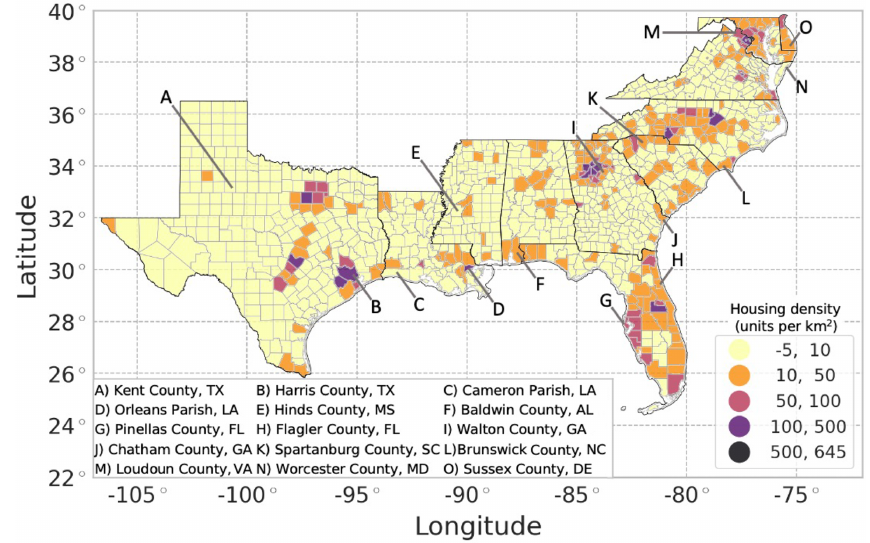
Figure 9. Projected 20-year change in housing unit density (2039 housing unit density minus 2019 housing unit density) using the REACH20 model (units per square